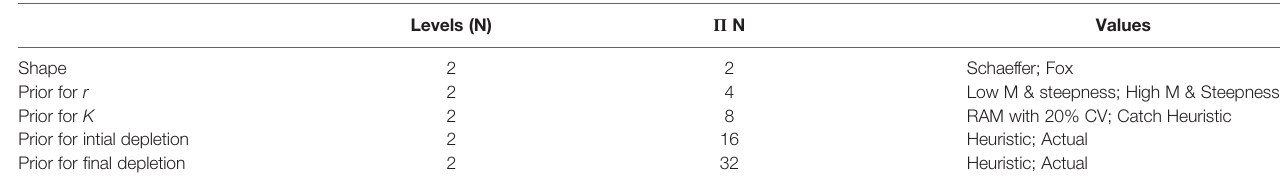
TABLE 1 | Catch-only model settings, for shape of the production function, and the derivation of population growth rate ( r ) from natural mortality and the steepness of the stock recruitment relationship, see Supplementary Material for details of derivation. Levels (N) П N Values Shape 2